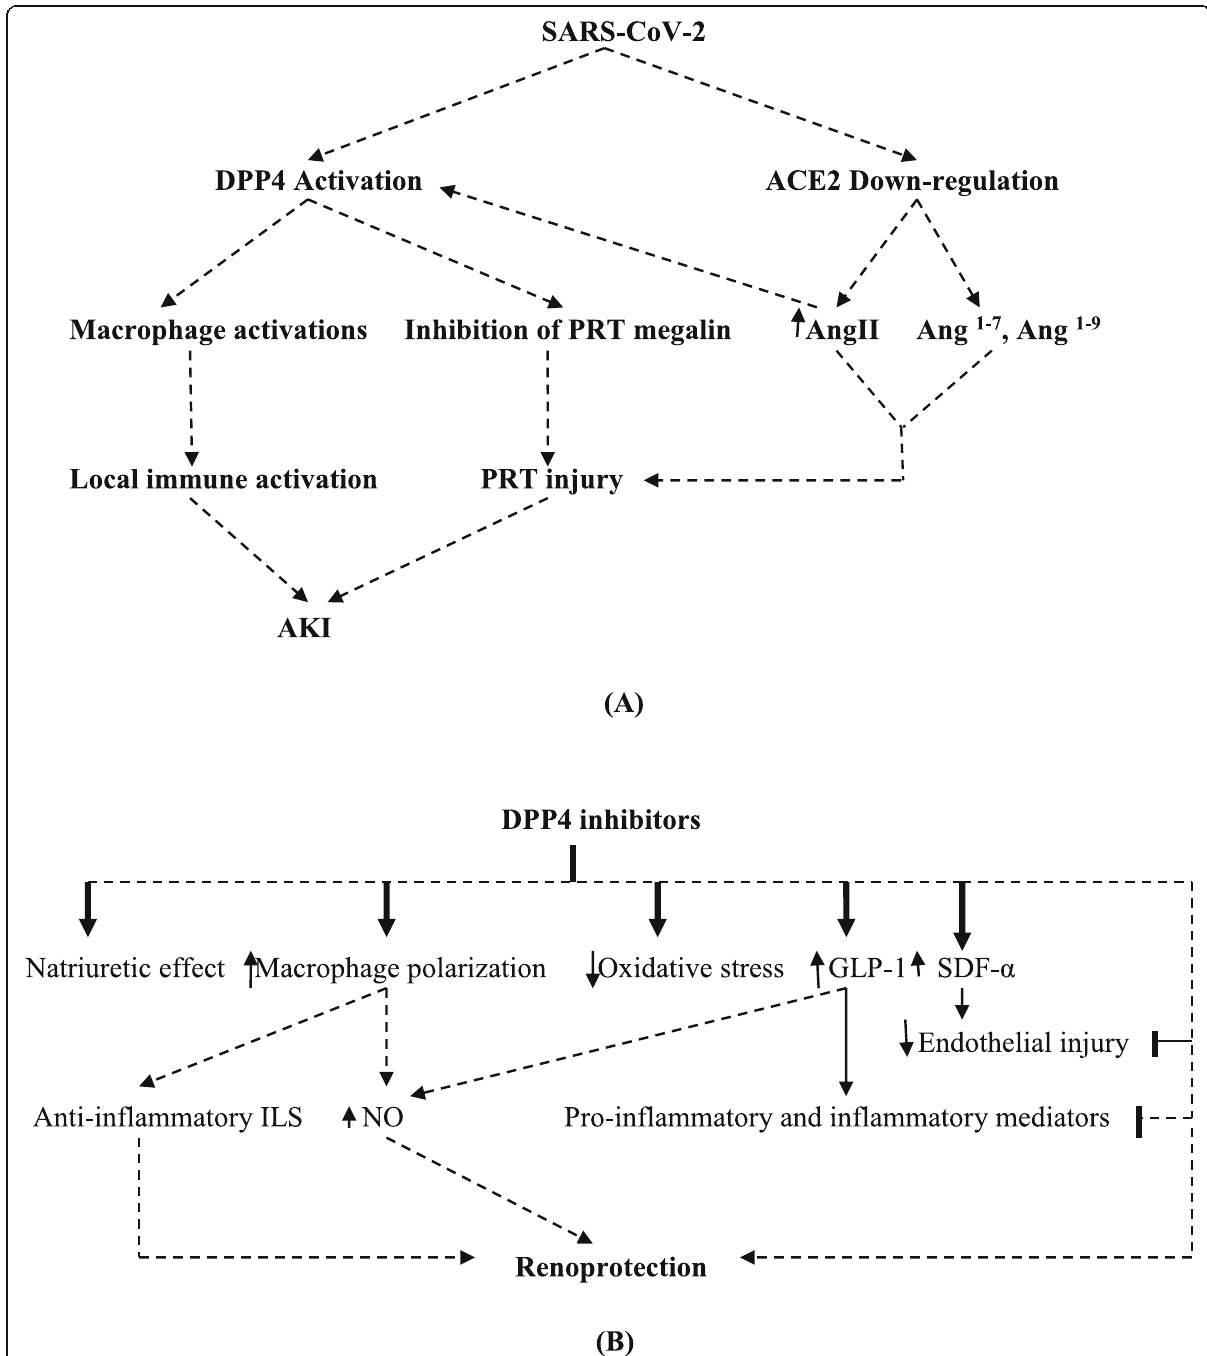
Fig. 1 Acute kidney injury in COVID-19; role of ACE2, DPP4, and DPP4 inhibitors. A Role of ACE2 and DPP4 in the pathogenesis of AKI. B : Role of DPP4 inhibitors in renoprotection. GLP1, glucagon like peptid-1; SDF- α , stromal-derived factor alpha; NO, nitric oxide; PRT, proximal renal tubule; Ang, angiotensin; DPP4, dipeptidyl peptidase